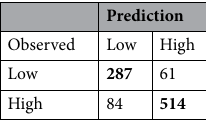
Table 3. RS-GBR-NMF-sparseLDA classification of Ki67 score post-treatment (test data).